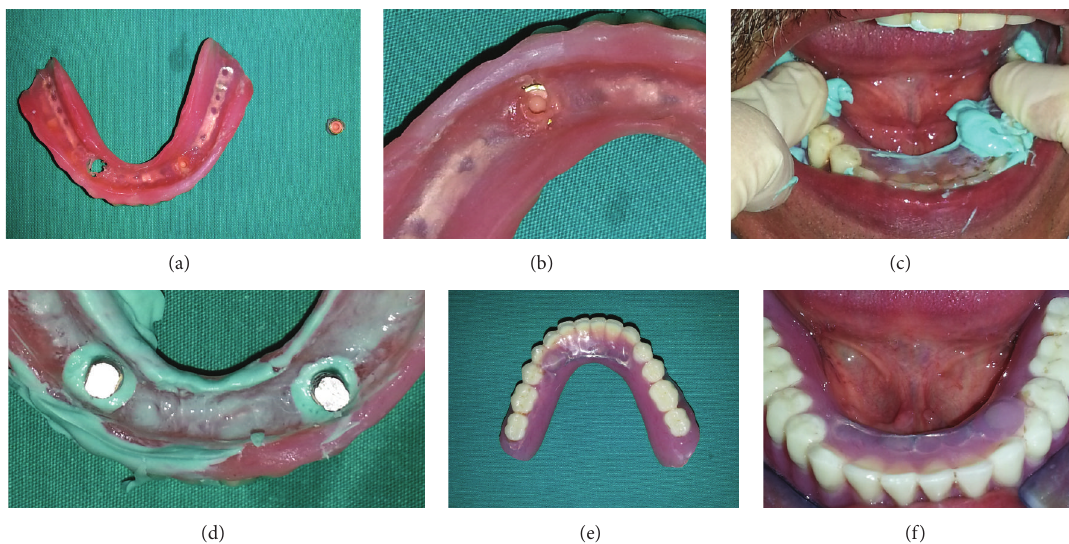
Figure 2: (a) View of theremoved matrix, (b)view of theexcessive resinmaterial, (c) making a new impression with light impressionmaterial, (d) placing the implant analogs, (e) view of the repaired denture, (f) placing the repaired denture to the